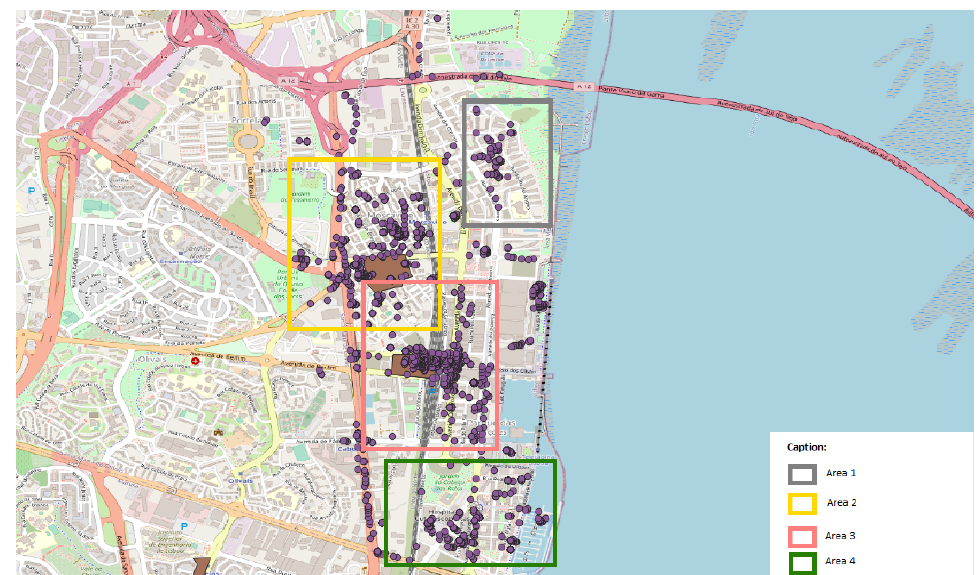
Figure 4. Interesting areas of devices concentration in Parque das Nações . Subway and train stations marked as brown. Background map source: OpenStreetMap [46].